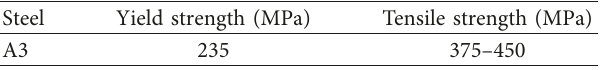
Table 1: Mechanical properties of steel used in blast tests.